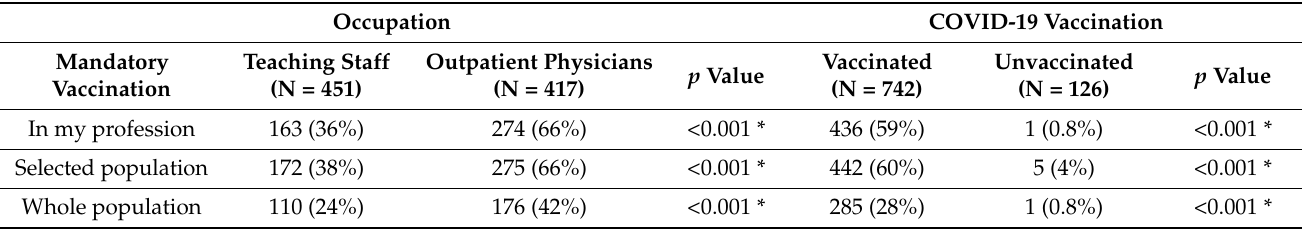
Table 7. Opinion on the introduction of mandatory vaccination against